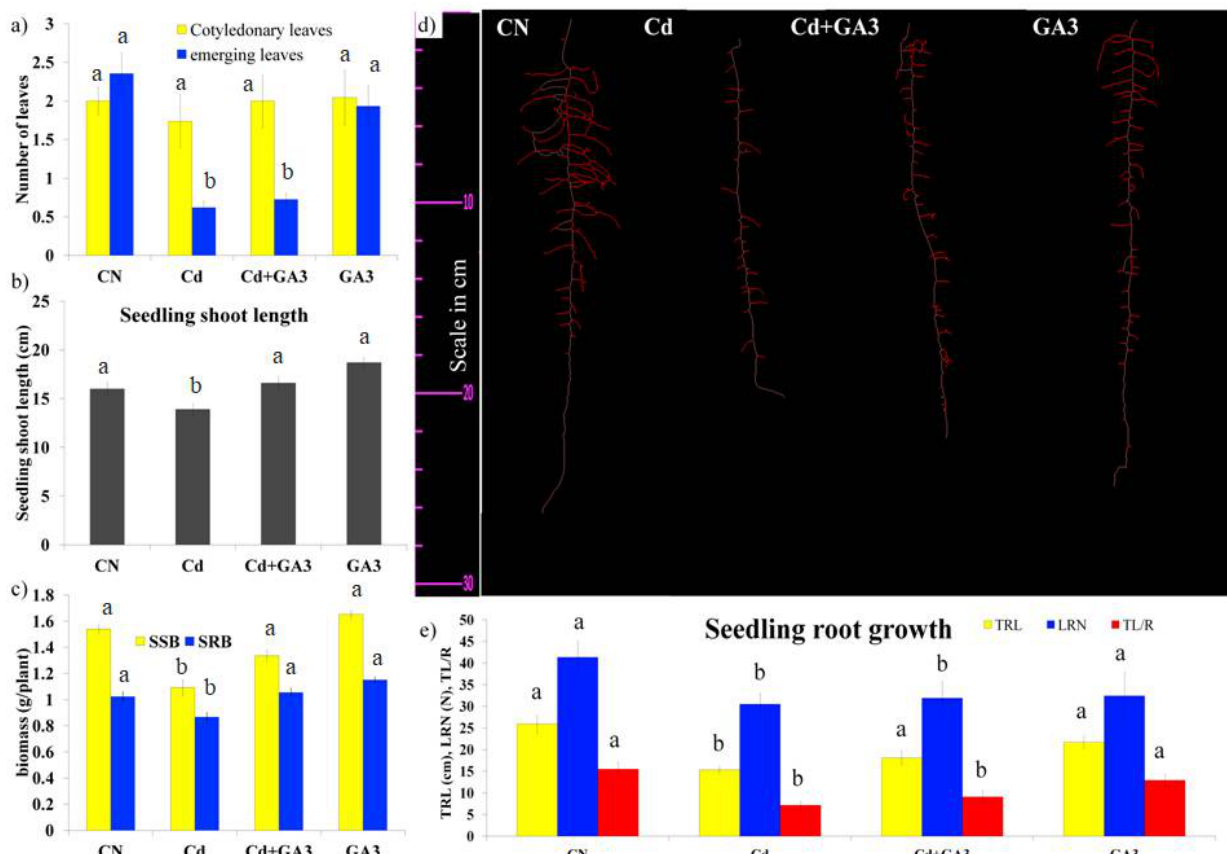
Figure 1. Effect of GA 3 on the growth of young mung bean plants under cadmium (Cd) stress in hydroponics.Effect of GA 3 with or without cadmium (Cd) stress on the number of cotyledonary and young emerging leaves ( a ), seedling shoot length ( b ), seedling shoot biomass (SSB) and seedling root biomass (SRB) ( c ), length of the root system ( d ), total root length (TRL), lateral root number (LRN), and total lateral roots (TLR)/R ( e ) in paper roll method grown under control (CN), cadmium (Cd) stress, Cd+ gibberellins (GA 3 ), and GA 3 alone conditions hydroponically. Data presented are means ± standard errors ( n = 10, biological replicates). Different letters (a, b) indicate significant differences from control in all combinations (Tukey’s test, p ≤ 0.05).